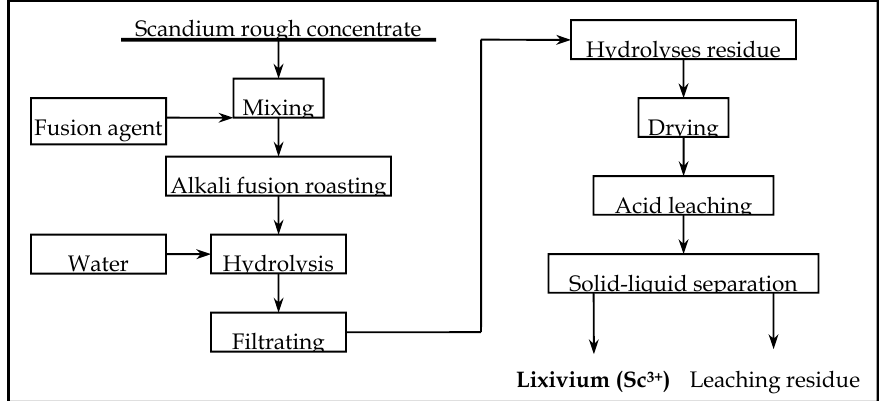
Figure 2. Scheme of the sandium separation process from scandium rough concentrate .